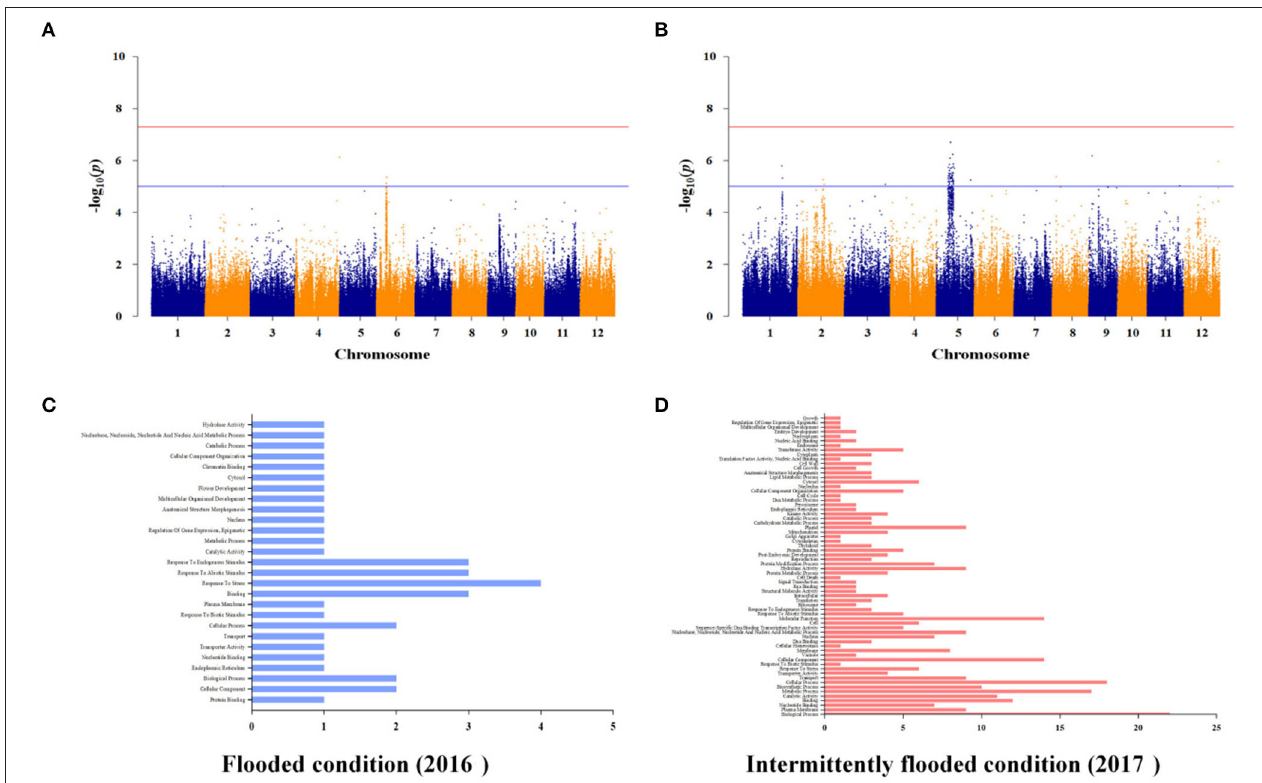
FIGURE 6 | Whole genome-scale profiling for As under flooded and intermittently flooded conditions in contaminated soil. (A) Significant SNPs with -log 10 ( p ) > 5 were identified on chromosome 6 under the flooded condition. (B) Significant SNPs with -log 10 ( p ) > 5 identified on chromosomes 1 and 5 under the intermittently flooded condition. (C) Ten candidate genes under the flooded condition were identified within strongly linked SNPs ( R 2 ≤ 1), and a number of candidate genes were involved in abiotic stress response. (D) The 150 candidate genes under the intermittently flooded condition were identified within strongly linked SNPs ( R 2 ≤ 1), and a number of candidate genes were involved in biosynthetic process, membrane, and plastid.